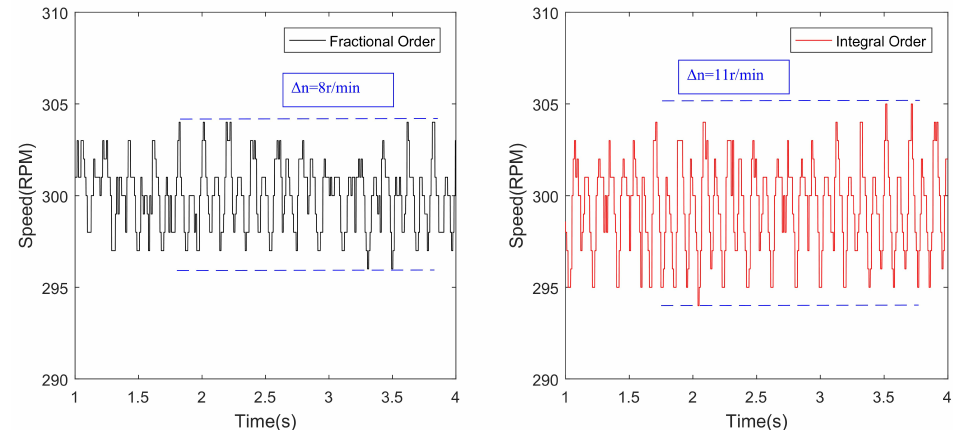
Figure 6. The speed fluctuation of motor at low speed.